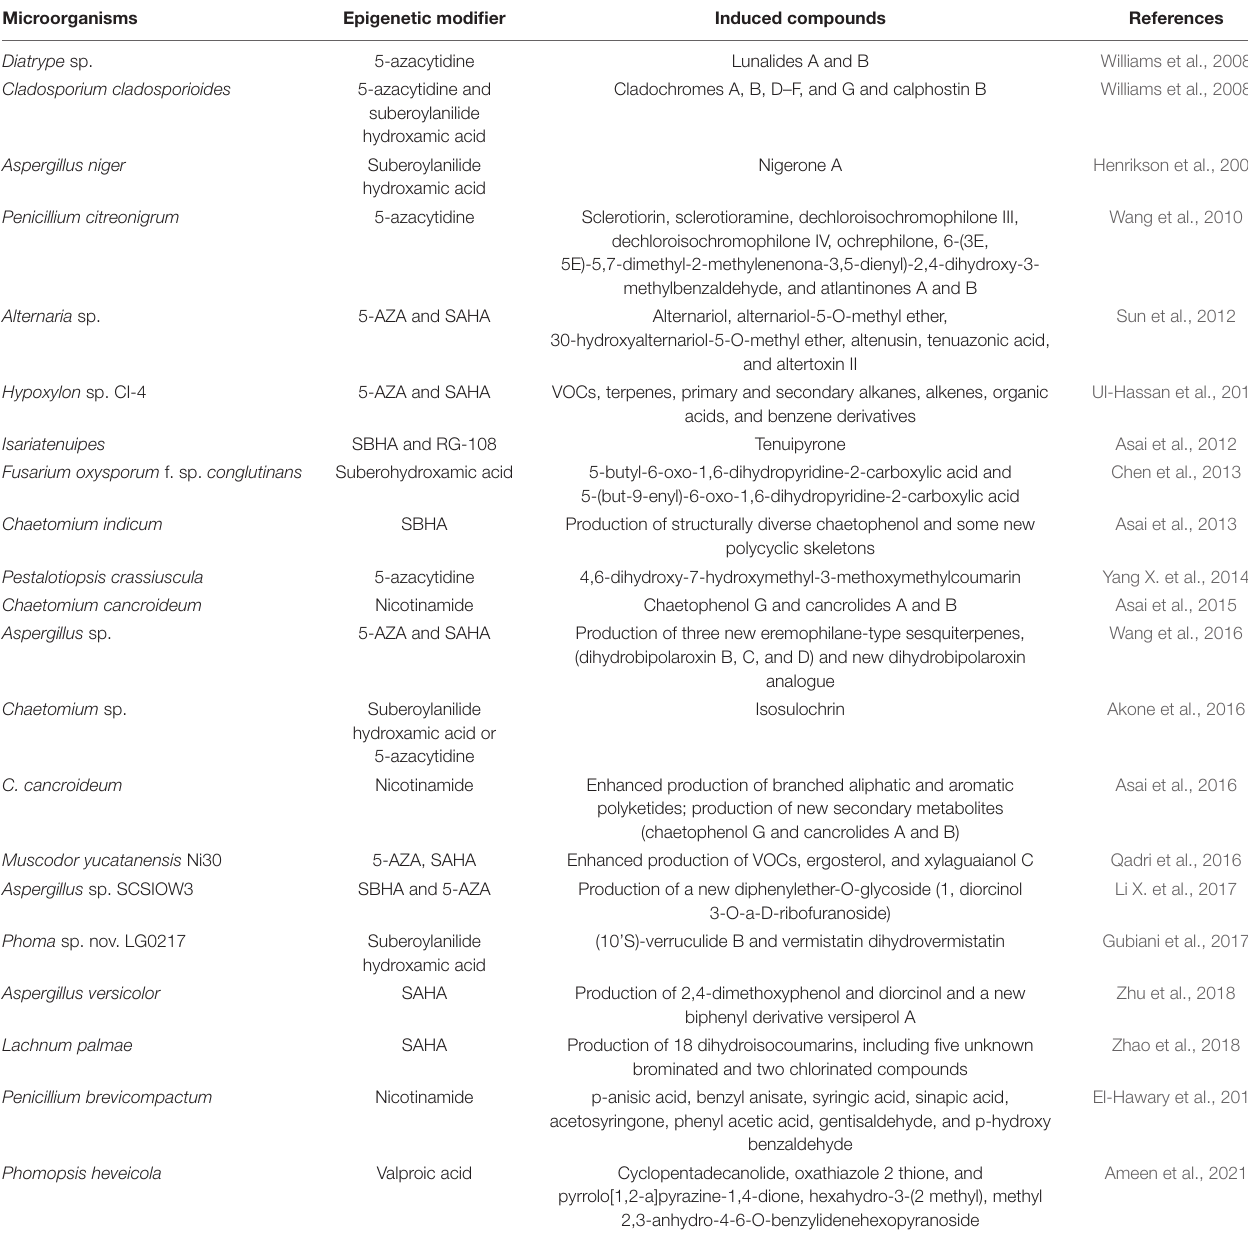
TABLE 1 | The effect of exposure of microorganisms to epigenetic